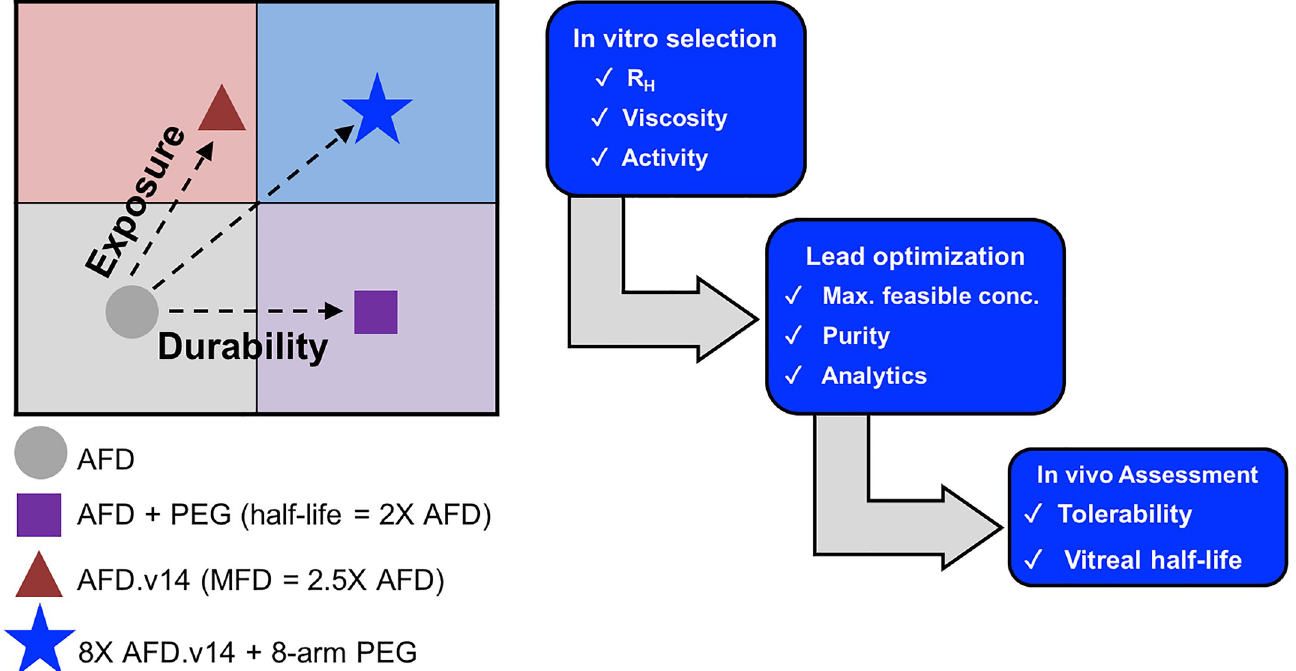
Fig 1. A. Schematic of the workflow process for selection, characterization and PK analysis of the novel Fab + PEG LAD system. B. By combining a Fab with improved formulation properties with a multivalent PEG scaffold, we were able to identify a next generation AFD.v14 + LAD with enhanced durability (x-axis) and exposure (y-axis) relative to AFD.v14 Fab